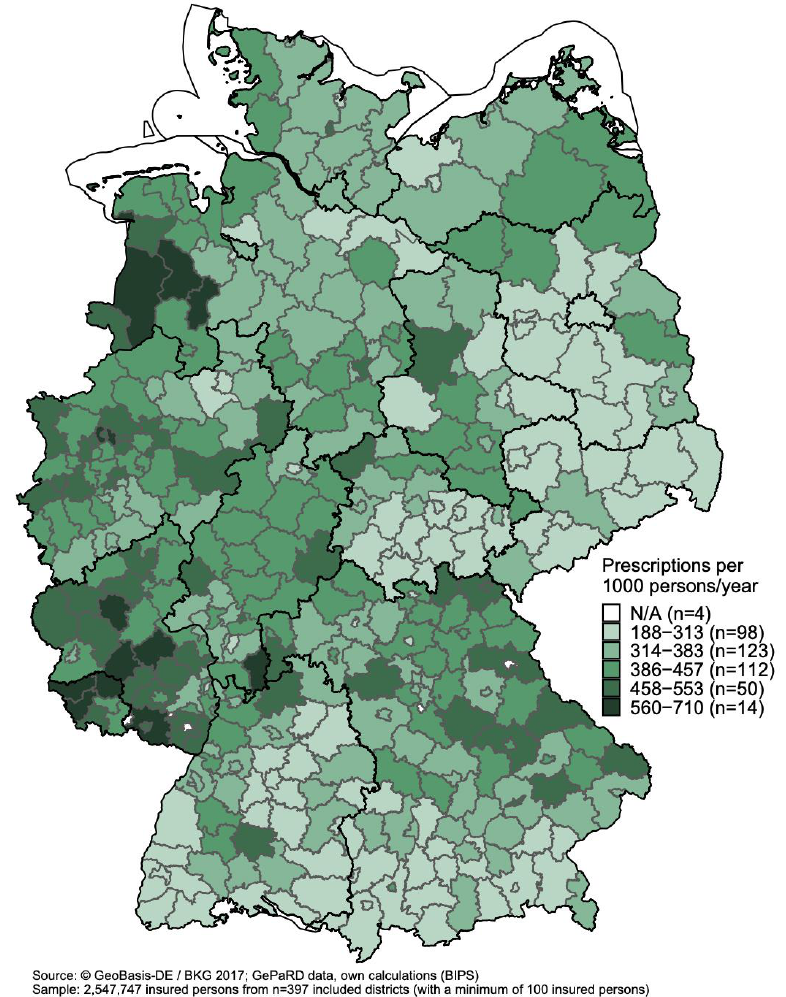
Figure 2. Age- and sex-standardized prescription rates (prescriptions per 1000 persons/year) of antibiotics among children and adolescents aged 0 – 17 years by district in 2018. Figure 3 shows the standardized prescription rates of antibiotics among adults aged ≥ 18 years (n = 14,075,311) in the German districts in 2018. Prescription rates ranged from 300 to 693 per 1000 persons/year across districts. In the lowest class comprising 109 dis- tricts, prescription rates ranged from 300 to 410 per 1000 persons/year; in the highest class comprising 15 districts, prescription rates ranged from 598 to 693 per 1000 persons/year. The 15 districts with the highest prescription rates were near the western border of Ger- many (except for Baden-Württemberg) and in Rhineland-Palatinate. Almost all districts in eastern Germany had prescription rates in the two classes with the lowest prescription